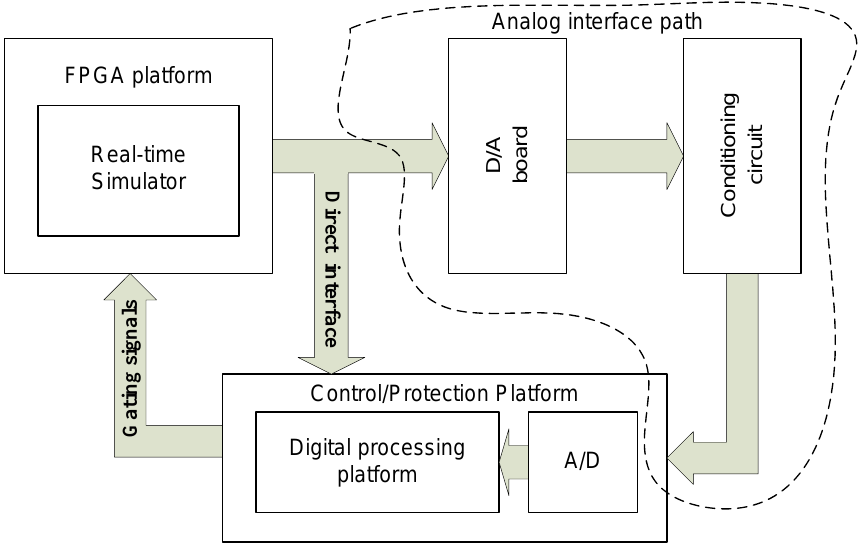
Figure 5. Simulator/controller interface